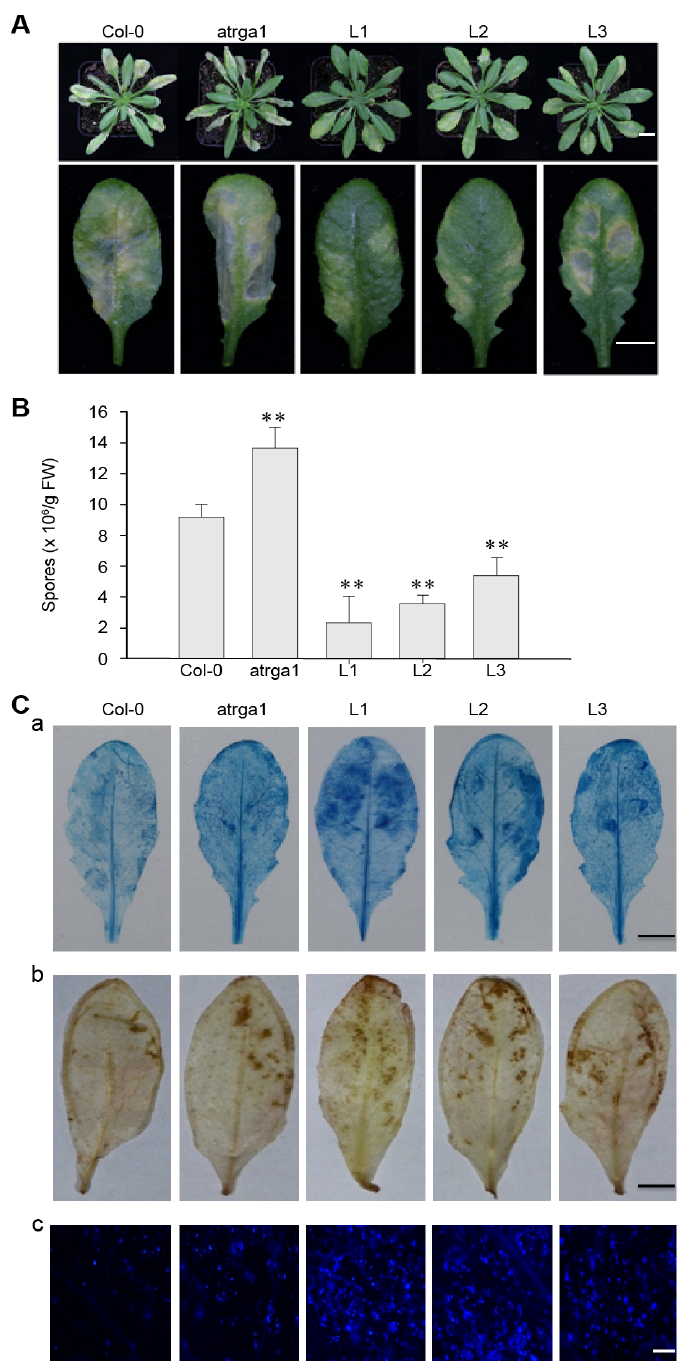
Figure 5. VaRGA1 expression in Arabidopsis improves resistance to Pst DC3000. Transgenic plants (L1, L2, L3), mutants ( atrga1 ), and non-transgenic controls (Col-0) were inoculated with Pst DC3000 for the following experiments. ( A ) The symptom of plants infected with Pst DC3000 5 dpi. The first scale bars = 20 mm. The second scale bars = 10 mm ( B ) Biological statistics on the number of spores per gram was carried out 2 dpi. Data represent mean values ± SD from three independent experiments. Asterisks show statistically significant di ff erence (** p < 0.01, Student’s t test). ( C ) Histochemical staining was carried out for the detection of cell death, H 2 O 2 accumulation, and superoxide anions (O2 − ) accumulation 3 dpi for (a) trypan blue, (b) diaminobenzidine (DAB), and (c) nitro blue tetrazolium (NBT) staining, respectively. Three independent experiments were conducted with 10 leaves per experiment. The black scale bars = 10 mm. The white scale bars = 0.5